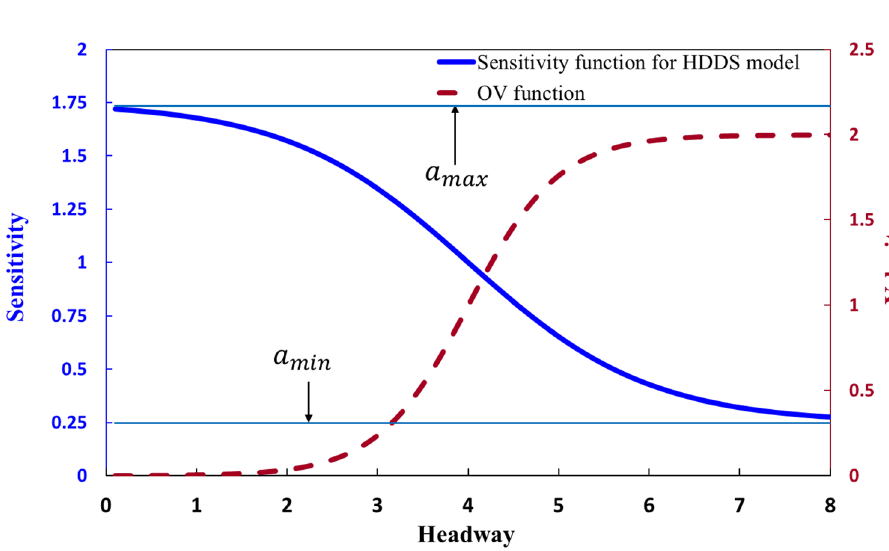
Figure 2. Line graphs for the tendency of sensitivity function (blue line) for